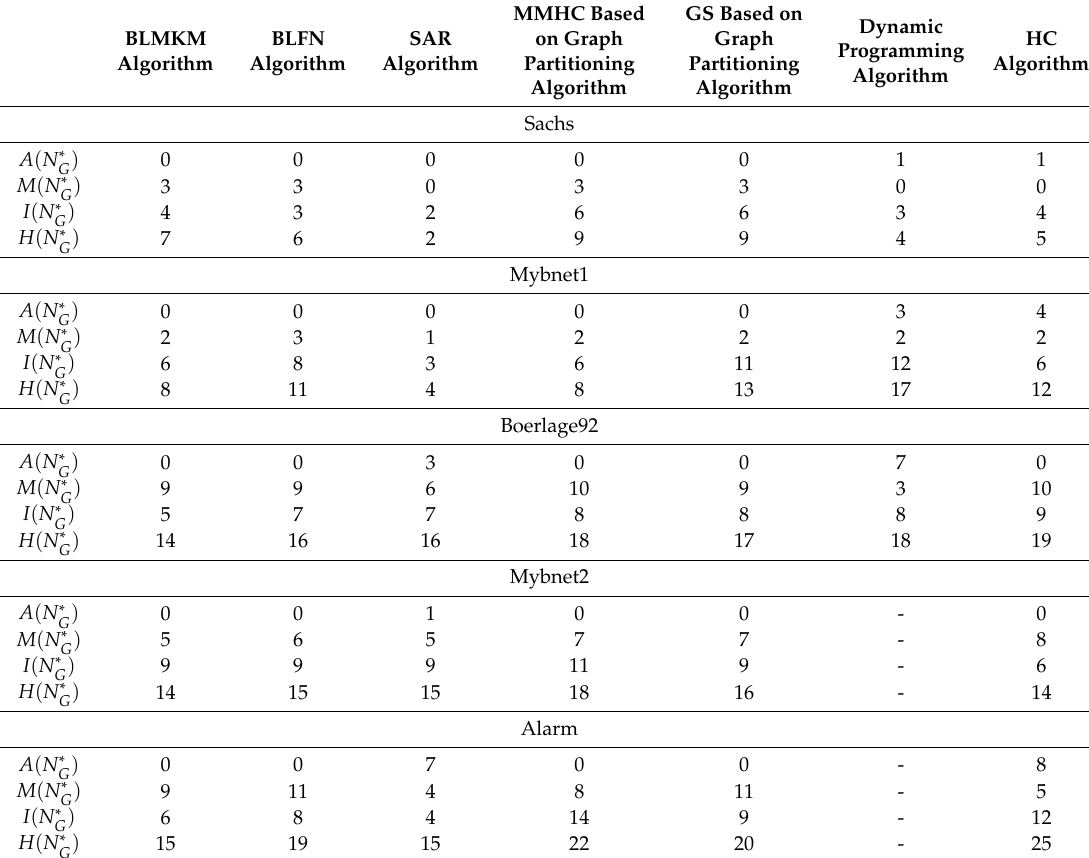
Table 2. The hamming distance of seven